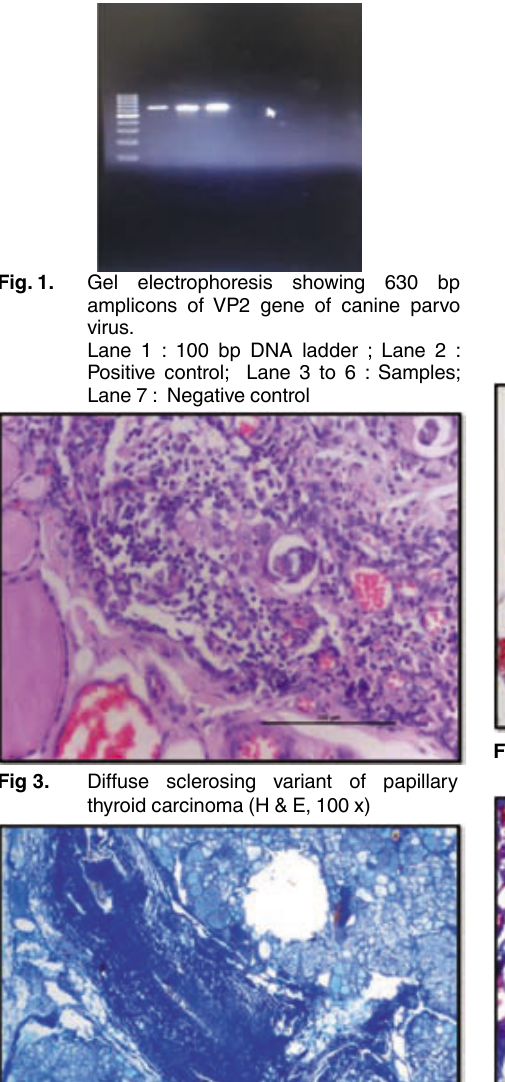
Fig 6. Fibrotic changes in thyroid parenchyma (Gomori’s one step trichrome stain, 400